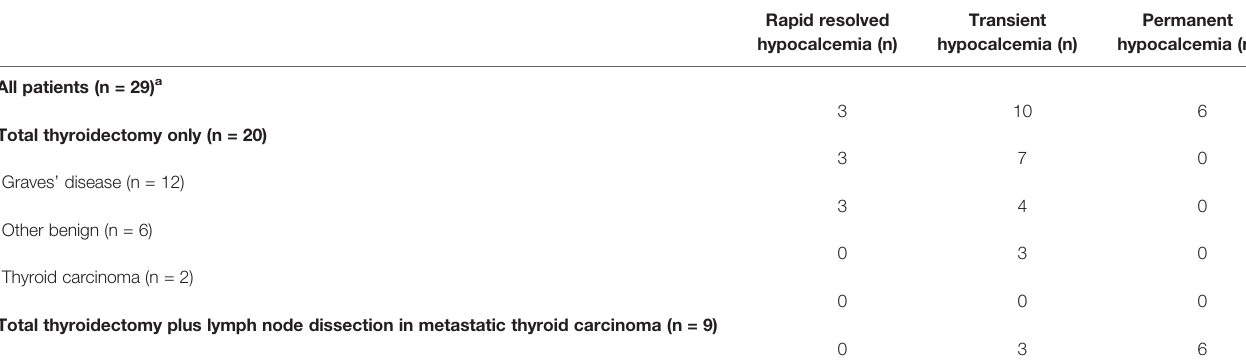
TABLE 3A | Postoperative hypocalcemia in pediatric patients who underwent a total thyroidectomy.